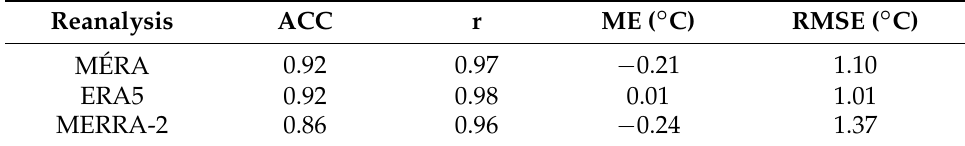
Table 2. Skill scores of each reanalysis compared to observations: anomaly correlation coefficient (ACC), Spearman’s correlation (r), mean error (ME), and root mean square error (RMSE) for hourly 2 m temperature averaged over all